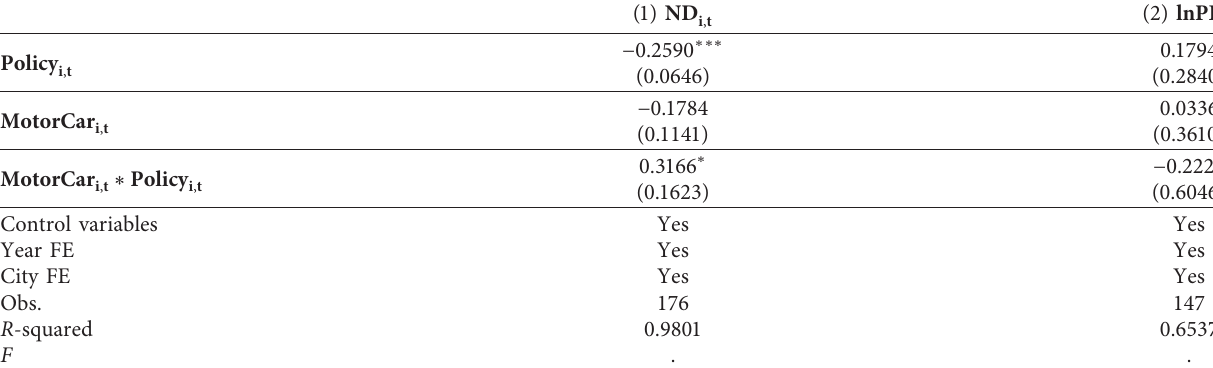
Table 8: The effect of policies on traffic accidents in cities with different amounts of